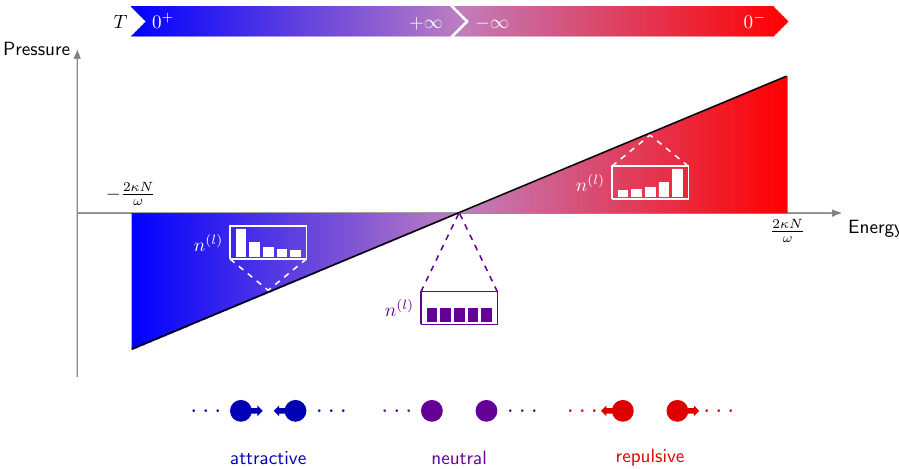
Fig. 2 Relation between the pressure and the internal energy in 1D waveguide arrays. Schematic showing the linear dependence of the optomechanical pressure from the total or internal energy of the electromagnetic fi eld, under thermal equilibrium conditions [see Eq. (2)] in one-dimensional arrays of evanescently coupled waveguides. Lower values of the energy are associated with negative pressure ensuing attractive forces between the waveguides. In addition, the optical temperature is positive and the power modal occupation numbers satisfy a Rayleigh-Jeans distribution that favors the lower-order modes. Note that there is a particular value of the energy where the distribution of the power occupation numbers becomes uniform, in which case the temperature is in fi nite, and the effective pressure between waveguides is zero. For higher values of energy, the pressure is positive, and thus the forces between waveguides become repulsive. The optical temperature is negative and the power modal occupation numbers satisfy a Rayleigh-Jeans distribution that favors the higher-order modes. The forces exerted between adjacent waveguides in an array are illustrated at the